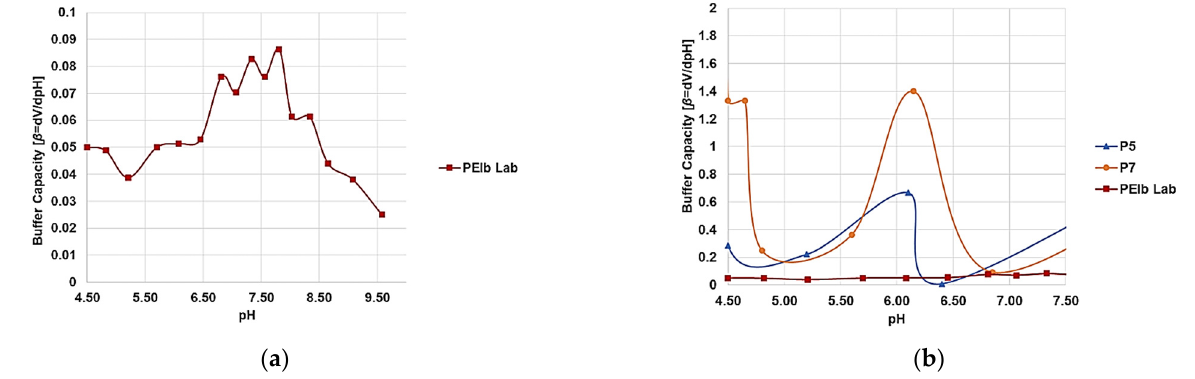
Figure 3. Buffer capacity curves of PEI- b 25 kD alone ( a ); buffer capacity curves of P5, P7, and PEI- b 25 kD ( b ).